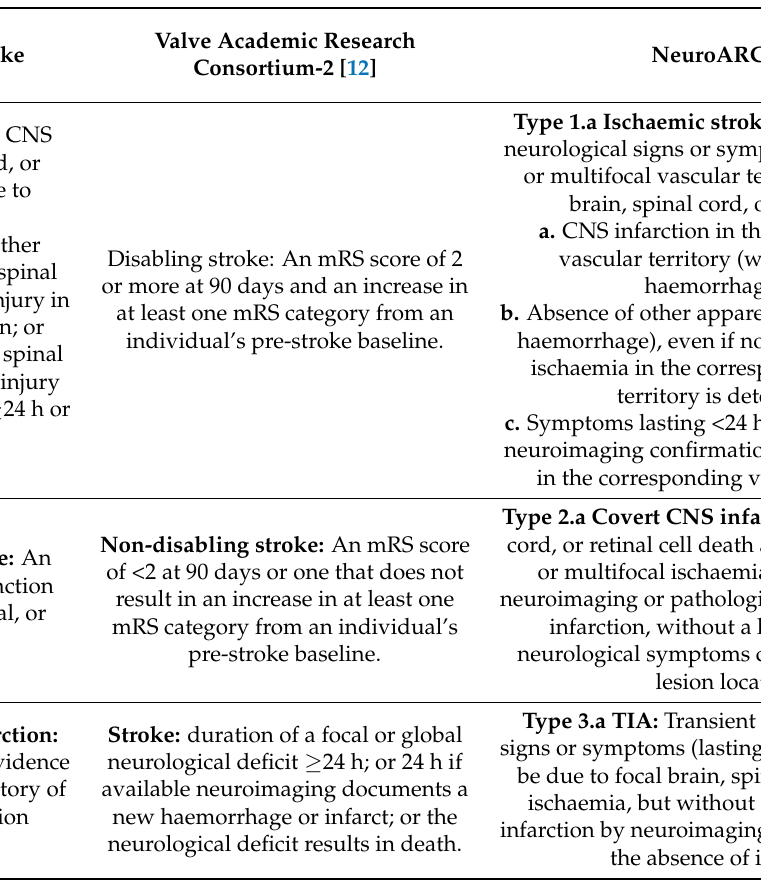
Table 1. Stroke definitions provided by international consensus